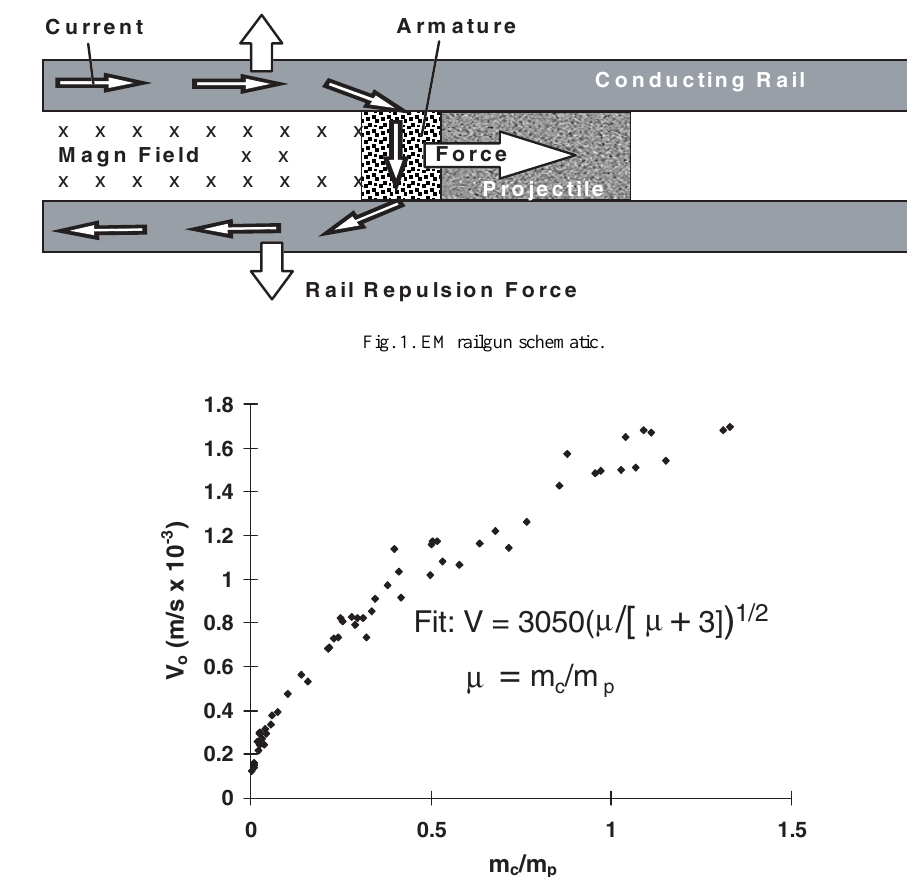
Fig. 1. EM railgun schematic.